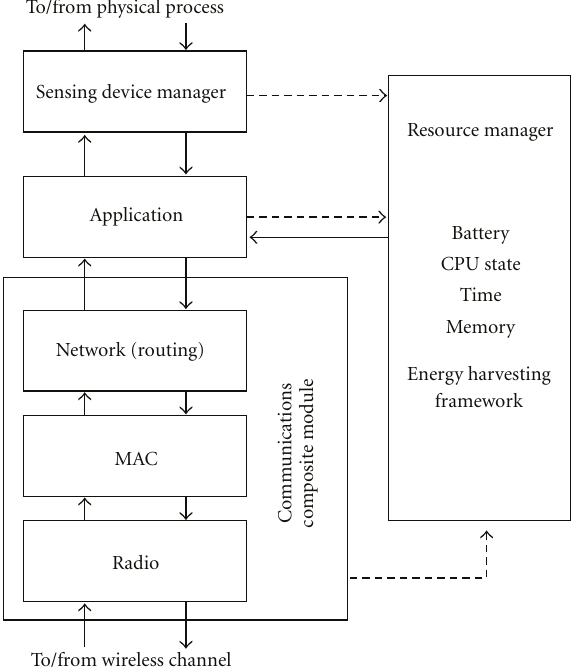
Figure 10: Internal structure of a node composite module in the Castalia simulator. We have extended the resource manager with our energy harvesting framework.